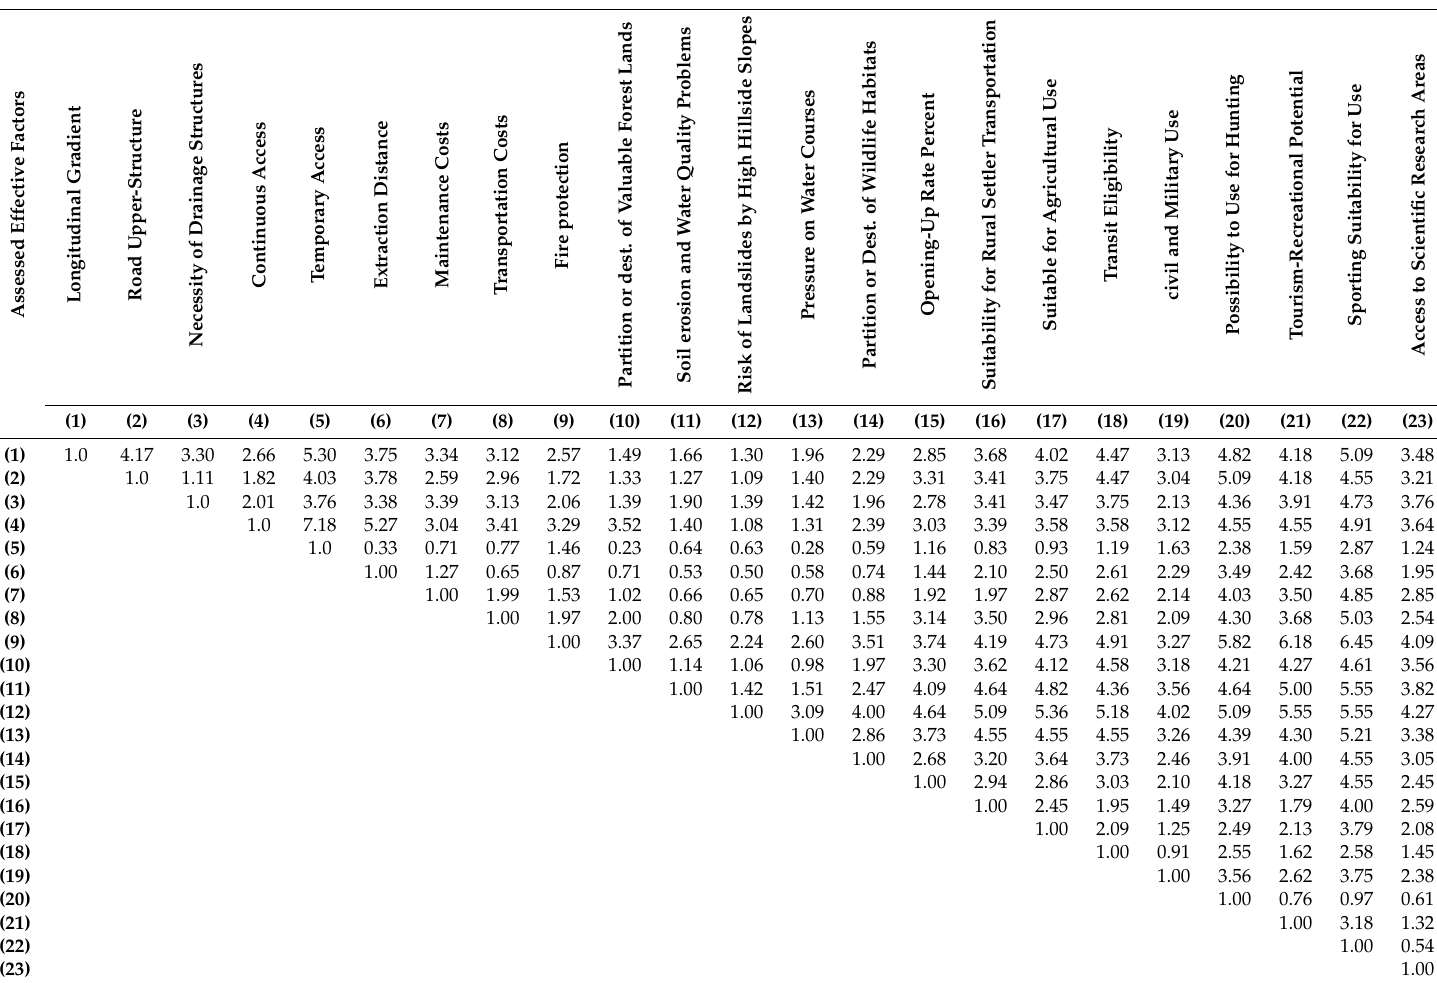
Table 2. Comparison matrix of average priority scores provided by questionaries’ filled out by the forest engineering department academic staff stakeholder group